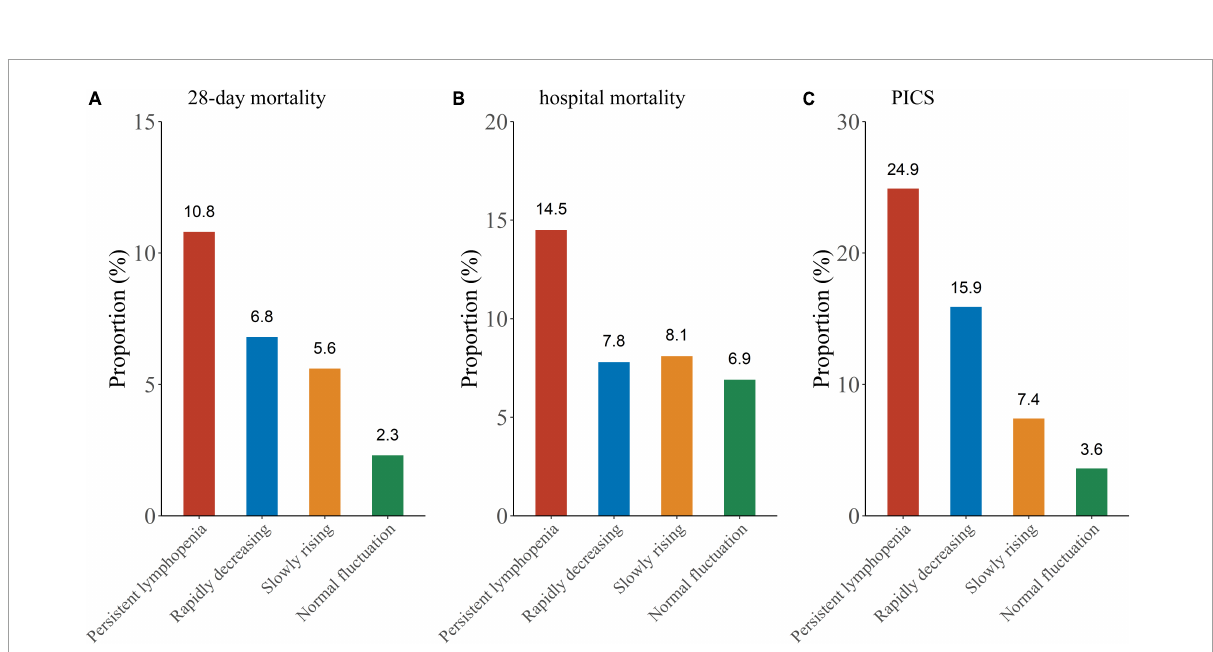
FIGURE4 Kaplan-Meier curves for 28-day mortality.